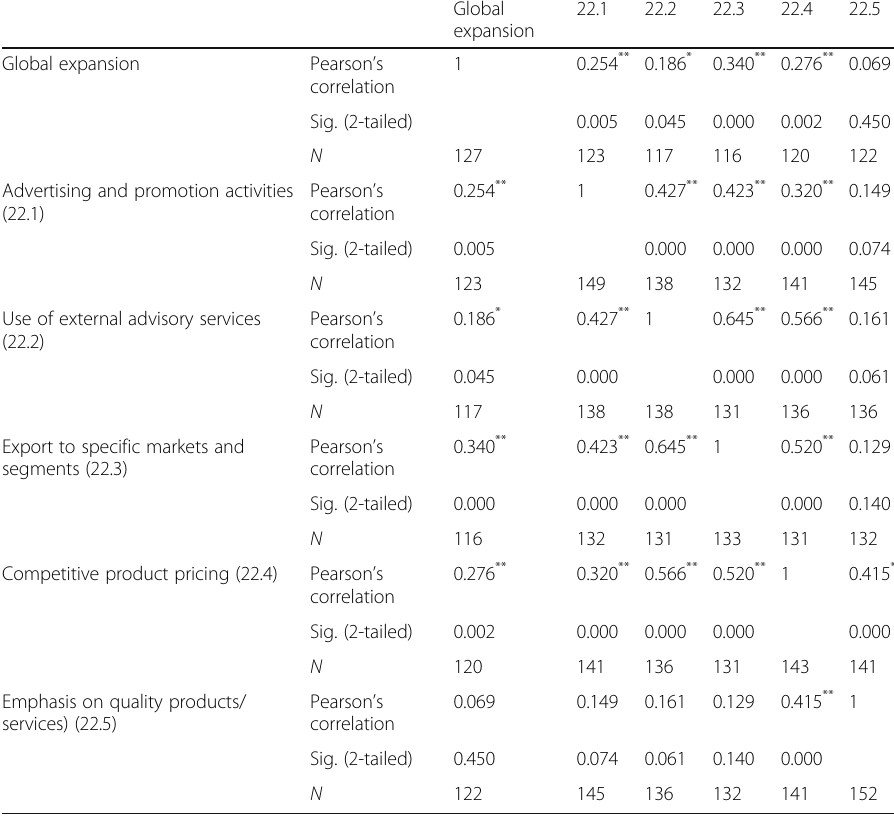
Table 4 Marketng strategy